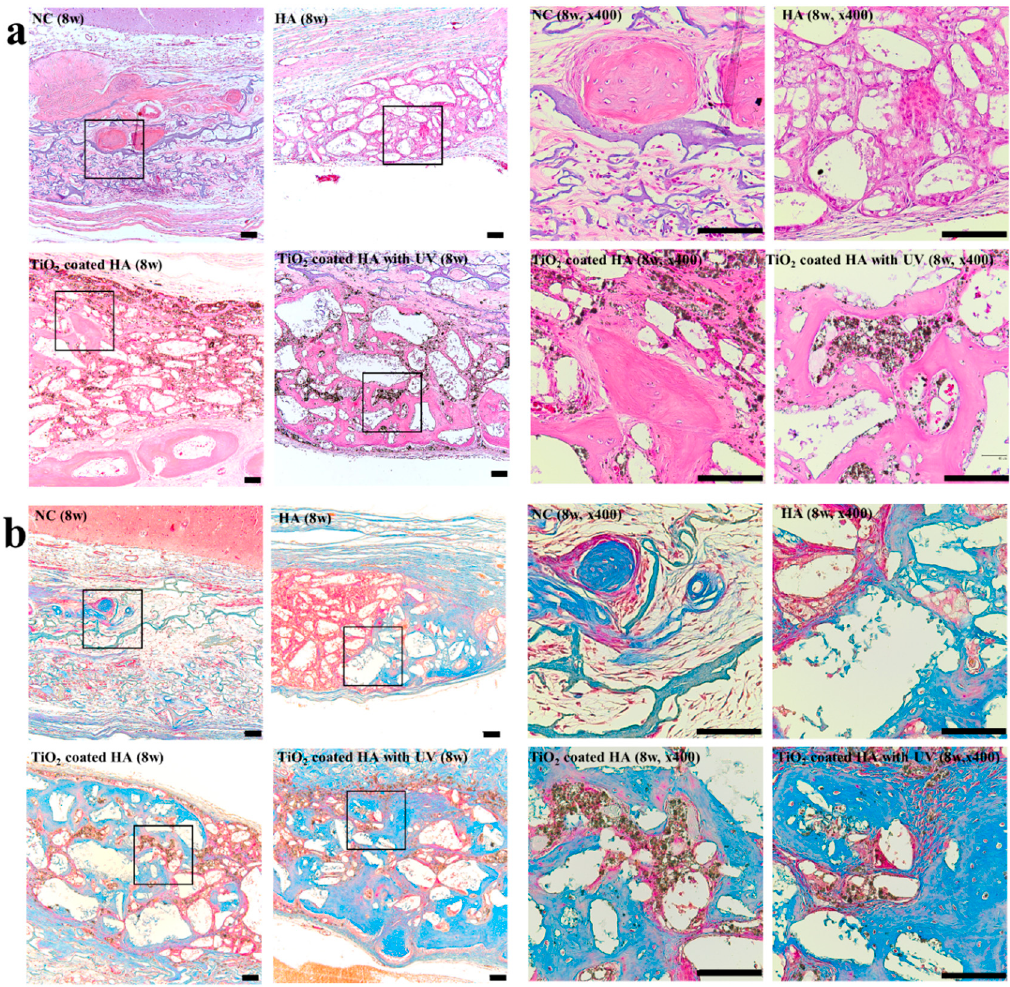
Figure 3. Histological findings (eight weeks). ( a ) Left : Light microscopy using H&E stain ( × 100) showing new bone formation in the groups at eight weeks postoperatively; NC group, HA group, TiO 2 -coated HA group, and TiO 2 -coated HA with UV group. The amount of new bone formation in all groups was greater than that at 2 weeks after surgery. New bone formation in the TiO 2 -coated HA with UV group was more distinct than that in the other groups. Right : Magnification of ( a ) ( × 400). Scale bar: 100 um. ( b ) Left : Light microscopy using Masson trichrome stain ( × 100) showing new bone formation in the groups at 8 weeks postoperatively; NC group, HA group, TiO 2 -coated HA group, and TiO 2 -coated HA with UV group. UV-treated group (lower-left). Right : Magnification of ( b ) ( × 400). Scale bar: 100 um.